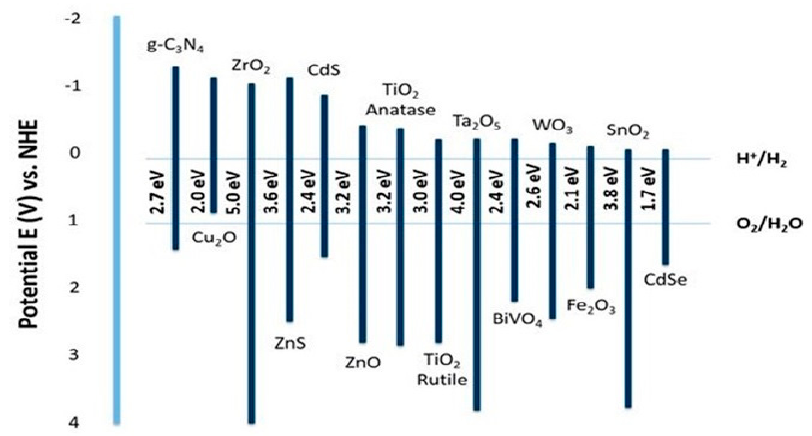
Figure 3. Bandgap positions of typical semiconductors for water-splitting. Reproduced from [42], with permission from MDPI, 2016.